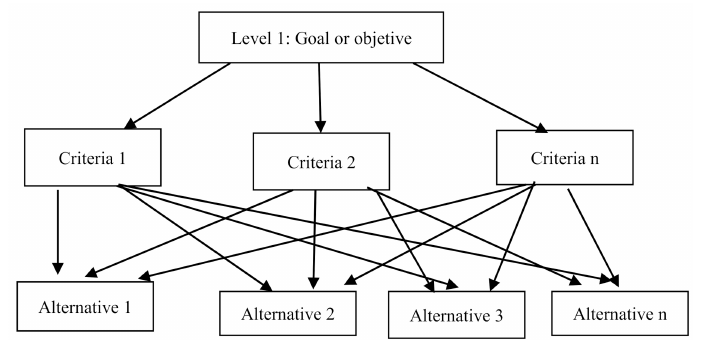
Figure 2. Hierarchy for the design of the first and second multi-criteria decision matrix.